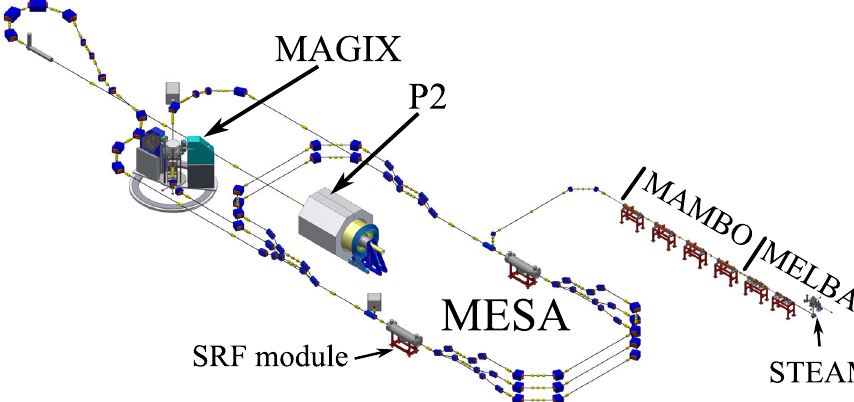
FIG. 1. Overview of the planned MESA